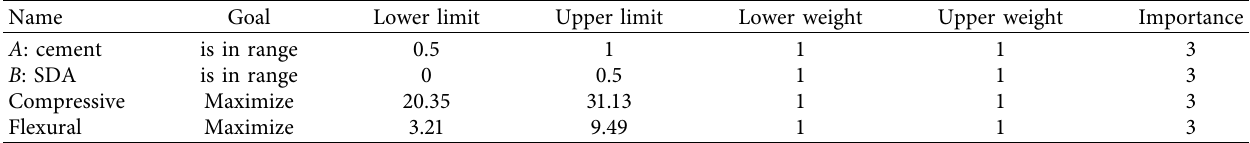
Table 23: Model variable criteria for optimization.